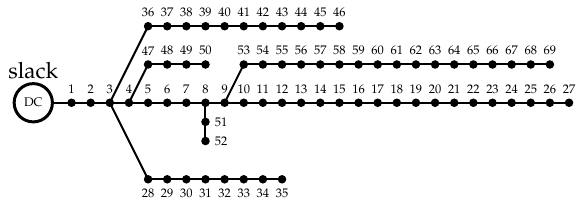
Figure 2. The 69-node system.